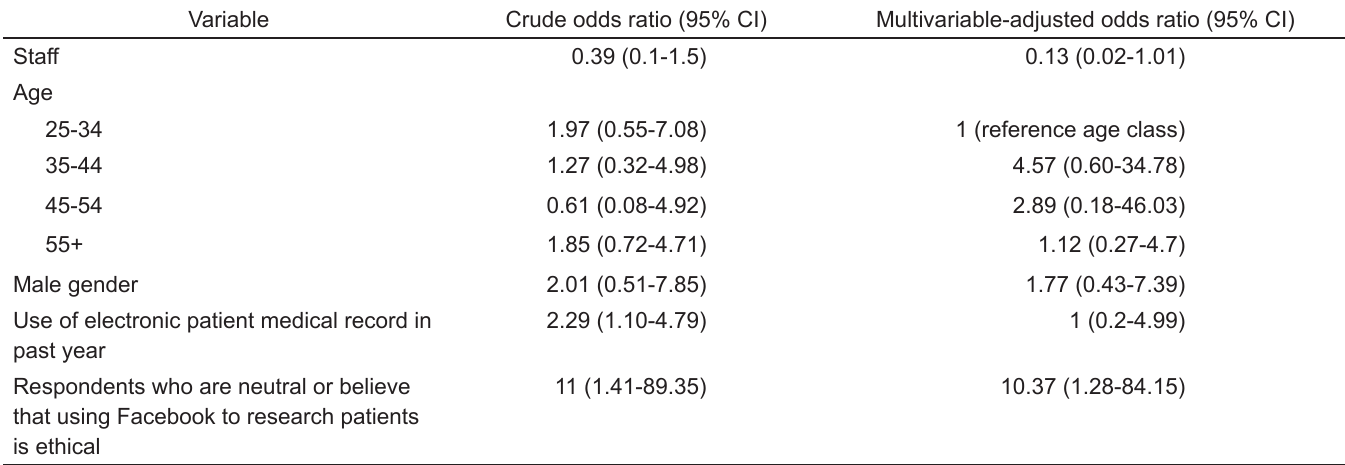
Table 3. Crude and multivariable-adjusted odds ratios of baseline variables for use of Facebook to research